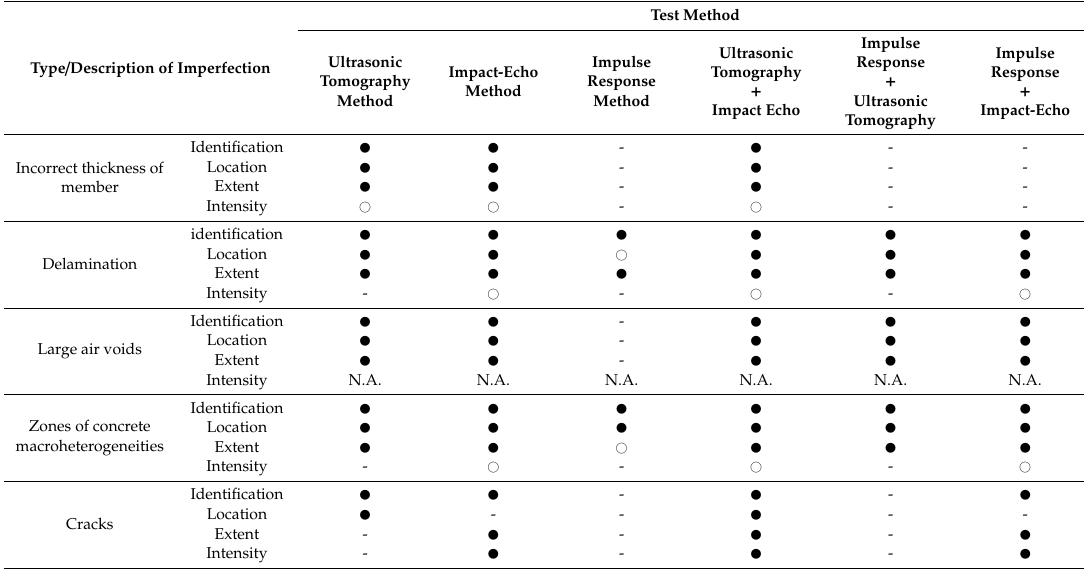
Table 1. Selected imperfections occurring in concrete structures, together with terms proposed for their description and assigned state-of-the-art non-destructive acoustic methods suitable for testing such structures [1].